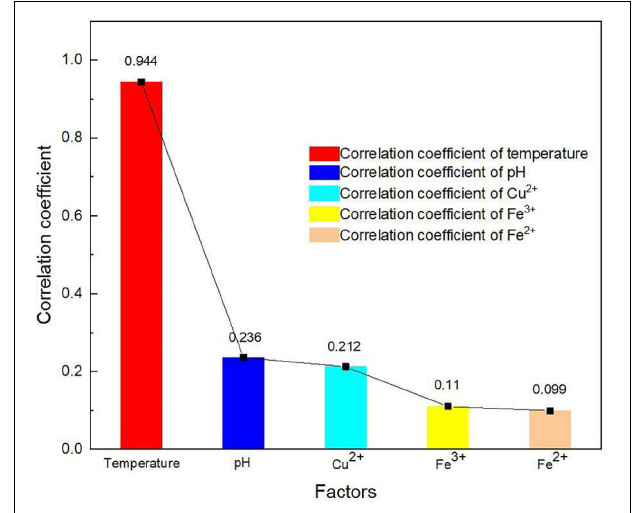
FIGURE 4 | Correlation coefficient of factors to dissolved oxygen